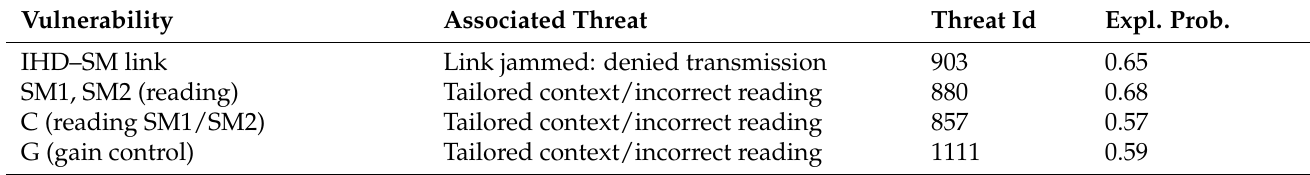
Table 11. Vulnerabilities, exploitation probabilities and associated threats for UC2.